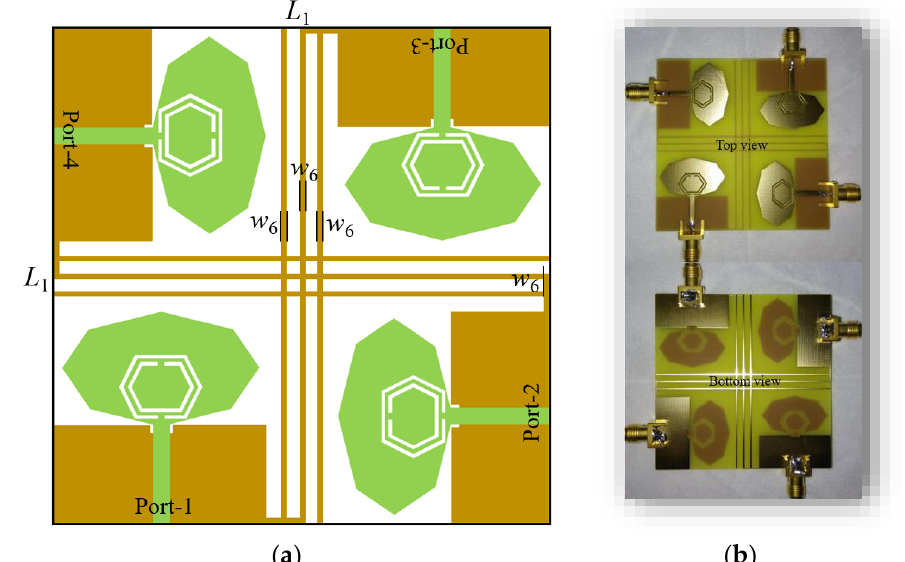
Figure 5. Proposed UWB MIMO antenna: ( a ) geometric layout; ( b ) prototype.